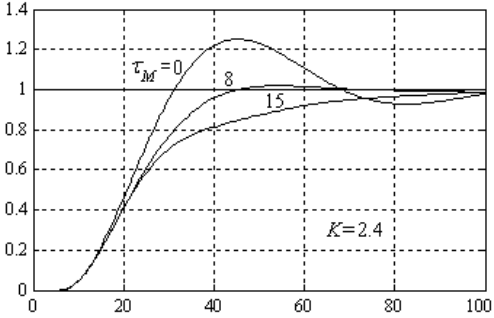
Figure 13. Responses y ( t ) to a unit step reference for K M = 1.5, T sM = 73 and τ M = 0; 8; 15.